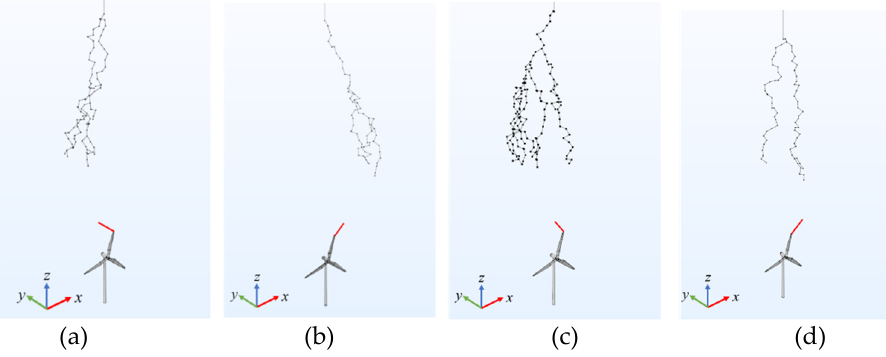
Figure 17. Typical cases of upward leader initiation on blade tip: ( a ) and ( c ) upward leader initiates on the back side of blade rotation, ( b ) and ( d ) upward leader initiates on the front side of blade rotation.